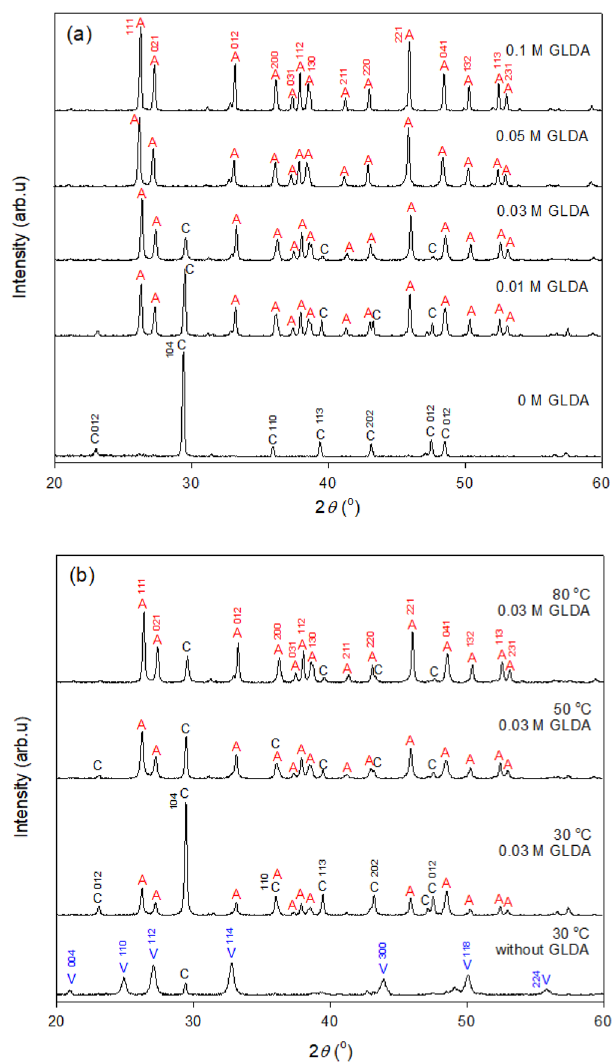
Figure 9. XRD patterns of precipitates formed during Ca carbonation ( a ) at 80 °C, GLDA concentrations of 0–0.1 M, and a Na 2 CO 3 concentration of 0.3 M and ( b ) at 30–80 °C, a GLDA concentration of 0.03 M and a Na 2 CO 3 concentration of 0.3 M. A: aragonite, C: calcite, V: vaterite.